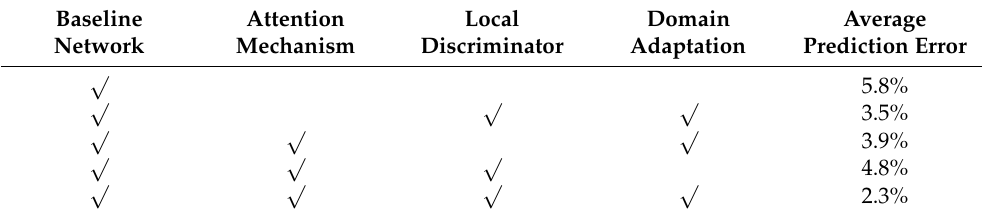
Table 3. Results of ablation